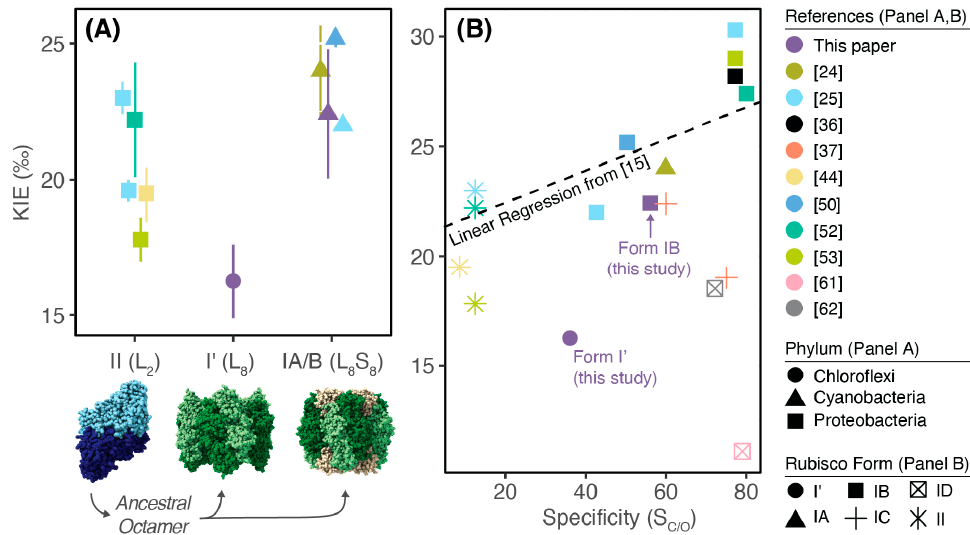
Figure 1. Form I’ rubisco fractionates less than both Form II and Form I rubiscos, and cannot be explained by prior model relating specificity and KIE. ( A ) KIE (‰) for relevant bacterial Form II (L 2 ), Form I’ (L 8 ), and Cyanobacterial Form IA/B (L 8 S 8 ) rubiscos with representative rubisco structures below; Protein Data Bank (PDB) codes from left to right: 5RUB, 6URA, 1RBL. Hypothesized evolutionary pathway is shown in black arrows, showing that ancestral dimers (L 2 ) likely evolved to a common ancestral octamer (L 8 ) [51] that then speciated into either Form I’ (L 8 ) or Form I (L 8 S 8 ) rubiscos [30]. Rubisco phylum is shown as shapes and references are shown in colors. Form II KIEs are from Rhodospirillum rubrum or Candidatus Endoriftia persephone [25,44,52,53], Form I’